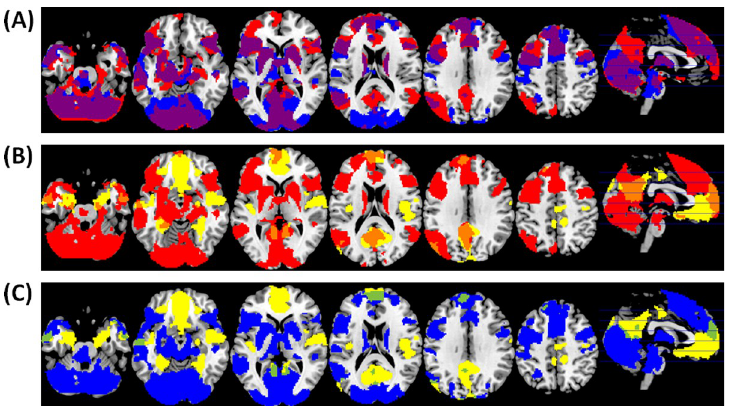
Fig 5. Overlap between activated areas in autobiographical memory and self-reflection, and deactivated areas in 2-back, compared to fixation. (A) Activation maps for autobiographical memory (red) and self-reflection (blue). Overlap is shown in purple. (B) Activation maps for autobiographical memory (red) and 2-back deactivation (yellow). Overlap is shown in orange. (C) Activation maps for self-reflection (blue) and 2-back deactivation (yellow). Overlap is shown in